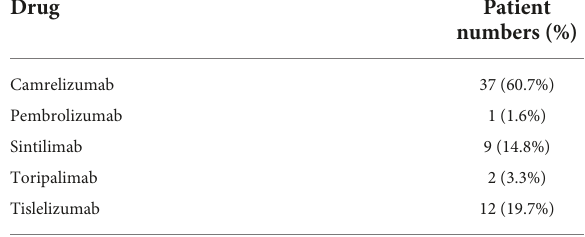
TABLE 2 The type of immune checkpoint inhibitors (ICIs).